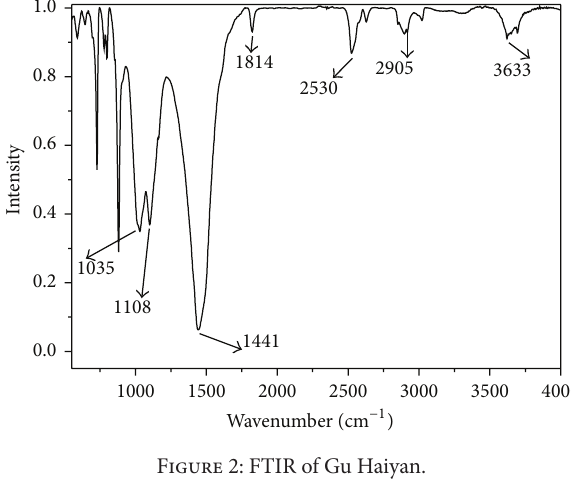
Figure 2: FTIR of Gu Haiyan.